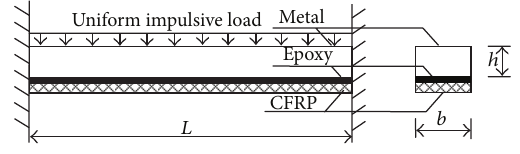
Figure 1: Schematic plot of hybrid